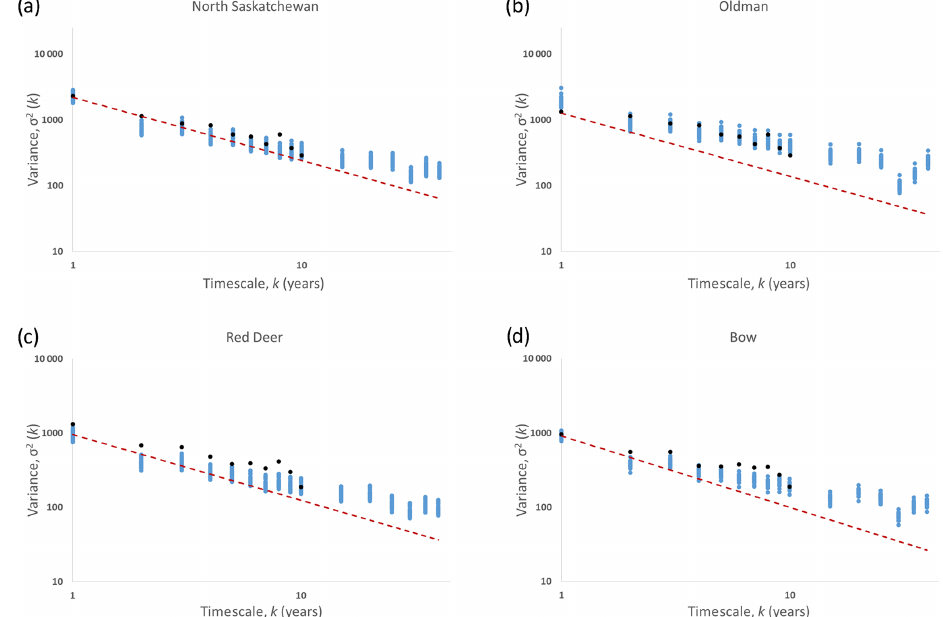
Figure 8. Variance versus timescale plot for reference and reconstructed flows in the (a) North Saskatchewan, (b) Oldman, (c) Red Deer and (d) Bow rivers. Black and blue time series represent reference and reconstructed flows, respectively, whereas the red line represents a random process with no long-term